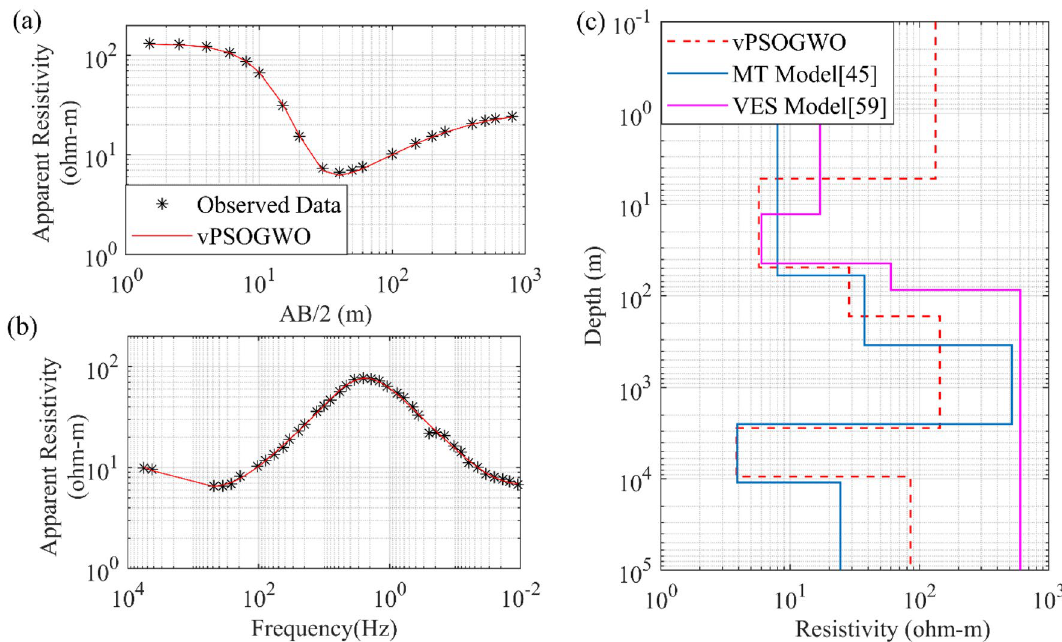
Figure 18. The inverted response by joint inversion based PSO, GWO, and vPSOGWO with a valid model (black) over Central Puga Valley, India: ( a ) DC observed and best-fitted apparent resistivity curves, ( b ) MT observed and best-fitted apparent resistivity curves and ( c ) 1D mean model (bpdf > 68.27% CI) inverted by vPSOGWO scheme